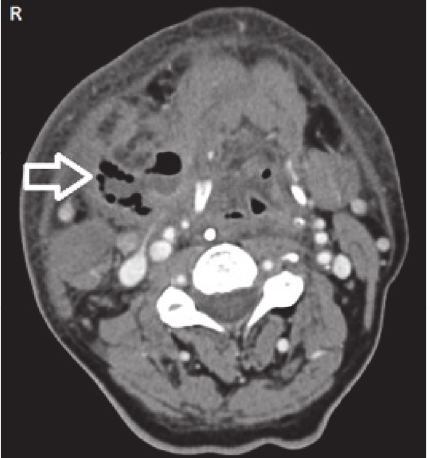
Figure 2: Axial neck CT image showing cervical subcutaneous gas (white arrow).